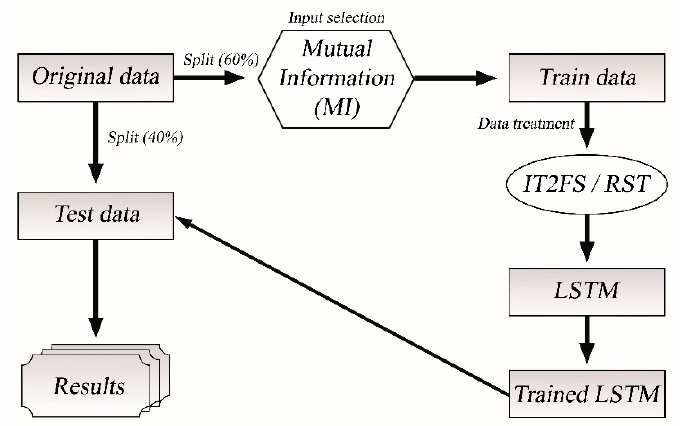
Figure 4. The flowchart of the proposed methodology and modeling strategy.